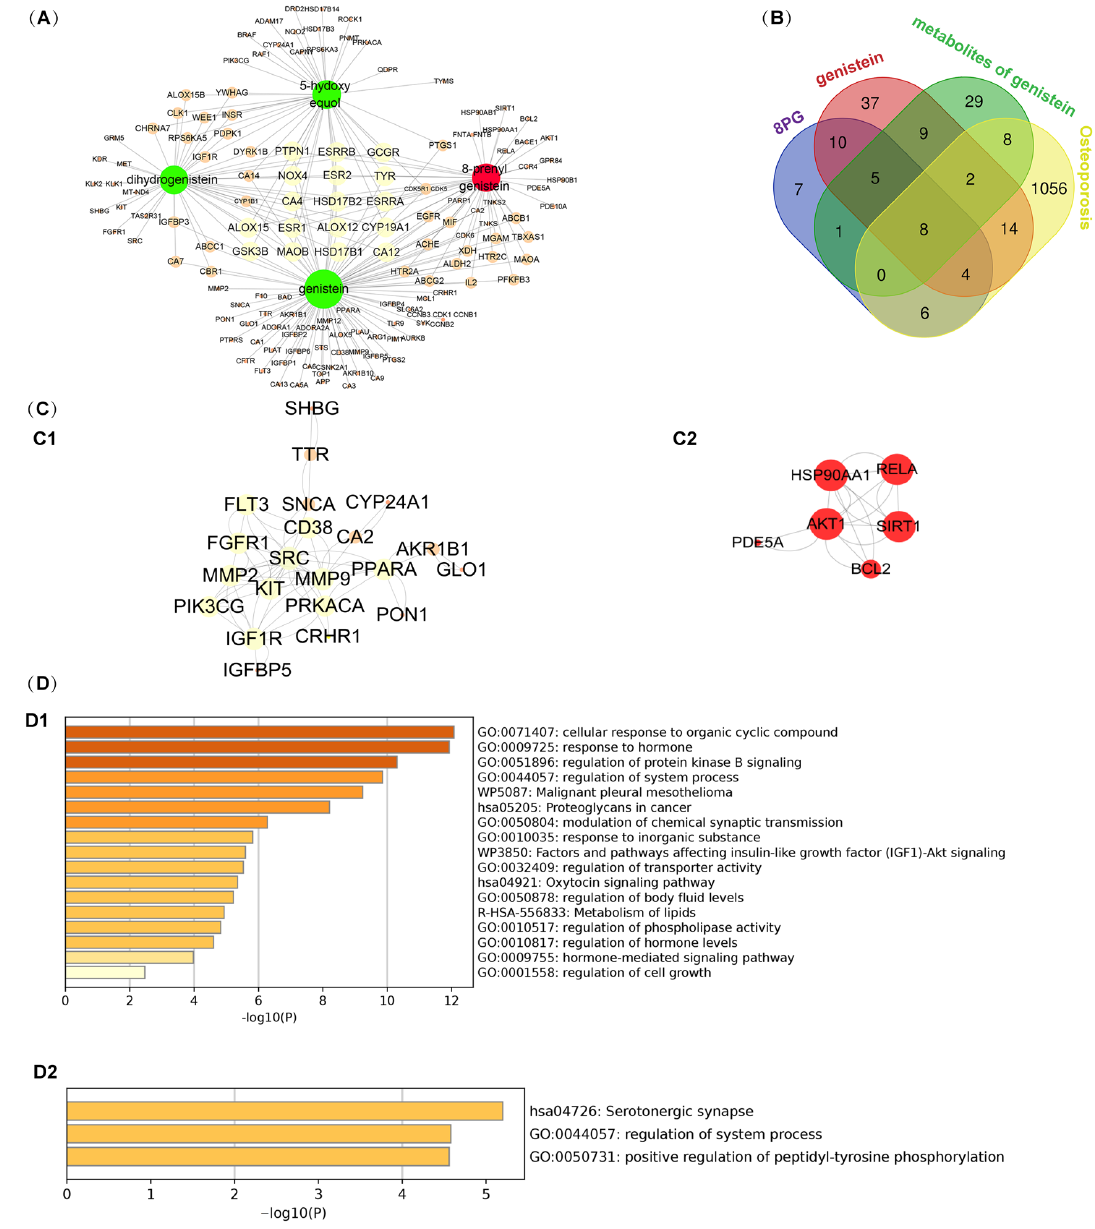
Figure 6. The predicted targets and pharmacological information of 8PG and genistein. ( A ) Compound-target network of 8PG, genistein, dihydrogenistein, and 5-hydoxy equol. ( B ) The overlapping targets between osteoporosis-related targets and the targets of 8PG, genistein, dihydrogenistein, and 5-hydoxy equol. ( C ) The protein–protein interactions among the overlapped targets, including genistein and its metabolites ( C1 ) and 8PG ( C2 ). ( D ) The enriched terms across input genes, including genistein and its metabolites ( D1 ) and 8PG ( D2 ).